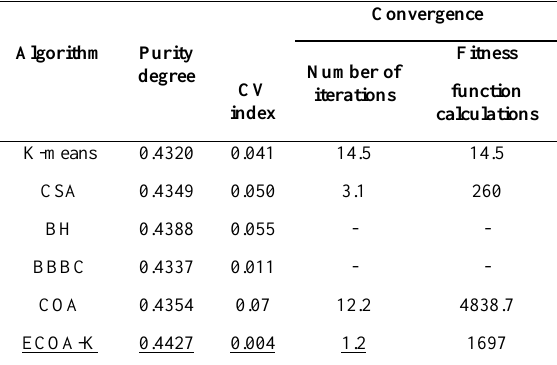
Table 5. Experimental results on CMC